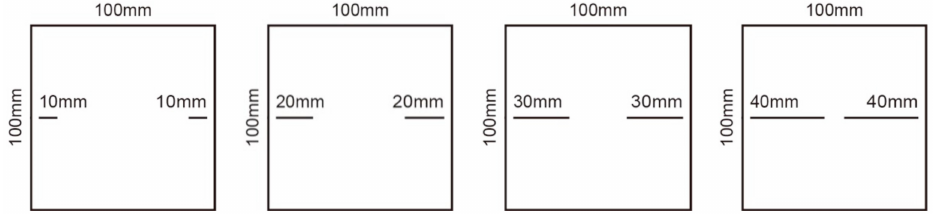
Figure 2. Schematic diagram of joint specimens in scheme I.